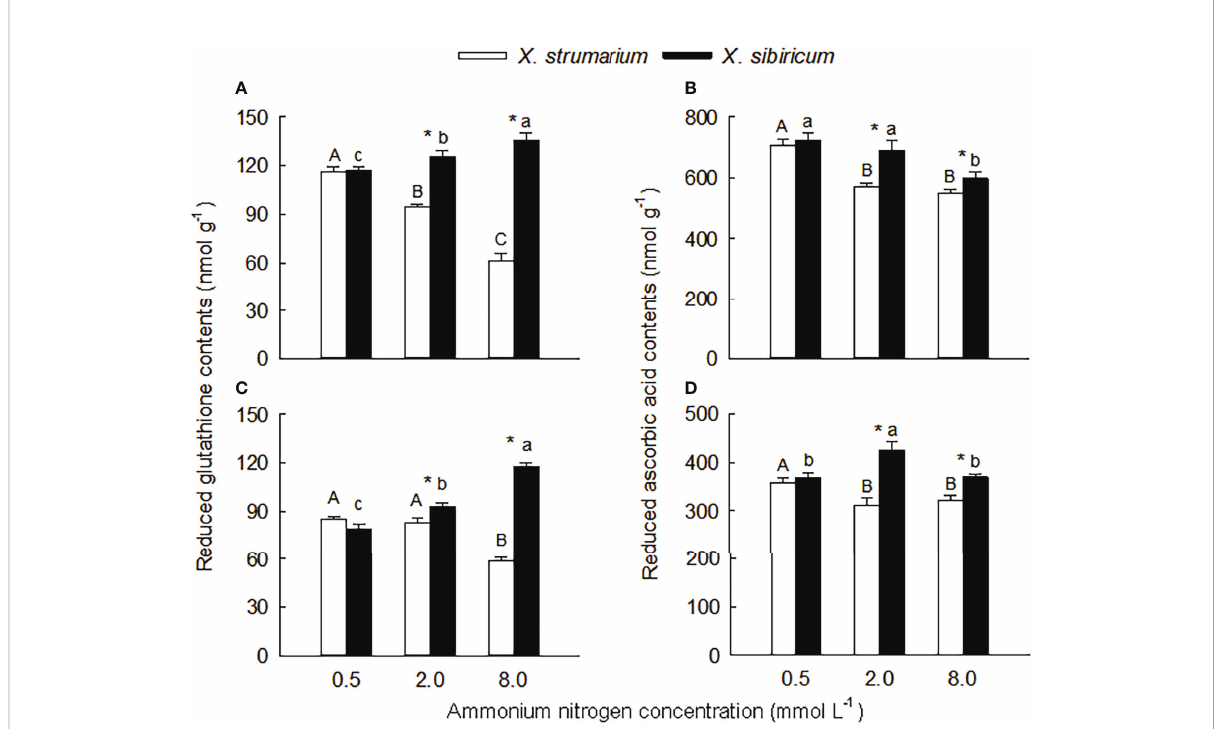
FIGURE 5 Differences in leaf (A, B) and fi ne root (C, D) contents of reduced glutathione (A, C) and ascorbic acid (B, D) between the invasive plant Xanthium strumarium and its native congener X. sibiricum under different ammonium levels. Means + 1 SE ( n = 6). Different upper- and lowercase letters indicate signi fi cant differences among ammonium treatments for X. strumarium and X. sibiricum , respectively ( P < 0.05; one- way ANOVA); * indicates signi fi cant difference between the two species under the same ammonium treatment ( P < 0.05; independent sample t - test). See Table S2 for the results of two-way